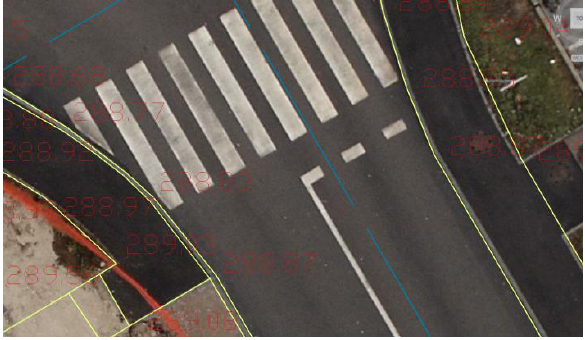
Figure 5. A subset of comparison of photogrammetric (ortho- photo) and control measurements Based on the comparison the accuracy of photogrammetric measurements was assessed to be 2 cm in horizontal direction and 3 cm in vertical direction.